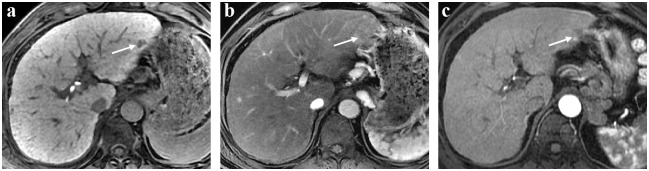
(A) Hepatobliiary phase (HBP) of gadoxetic acid-enhanced MRI, showed a hypointense nodule (arrow), which was considered as a liver nodule that showed a signal that was lower than that in the surrounding normal liver parenchyma. (B) Arterial phase of gadoxetic acid-enhanced MRI, showed a hypovascular nodule (arrow), which was defined as a liver nodule showing no evidence of arterial phase enhancement compared to that in the adjacent normal liver parenchyma. (C) Arterial phase of the follow-up MRI, showed vascularization development, which was defined as enhancement of the HHN.